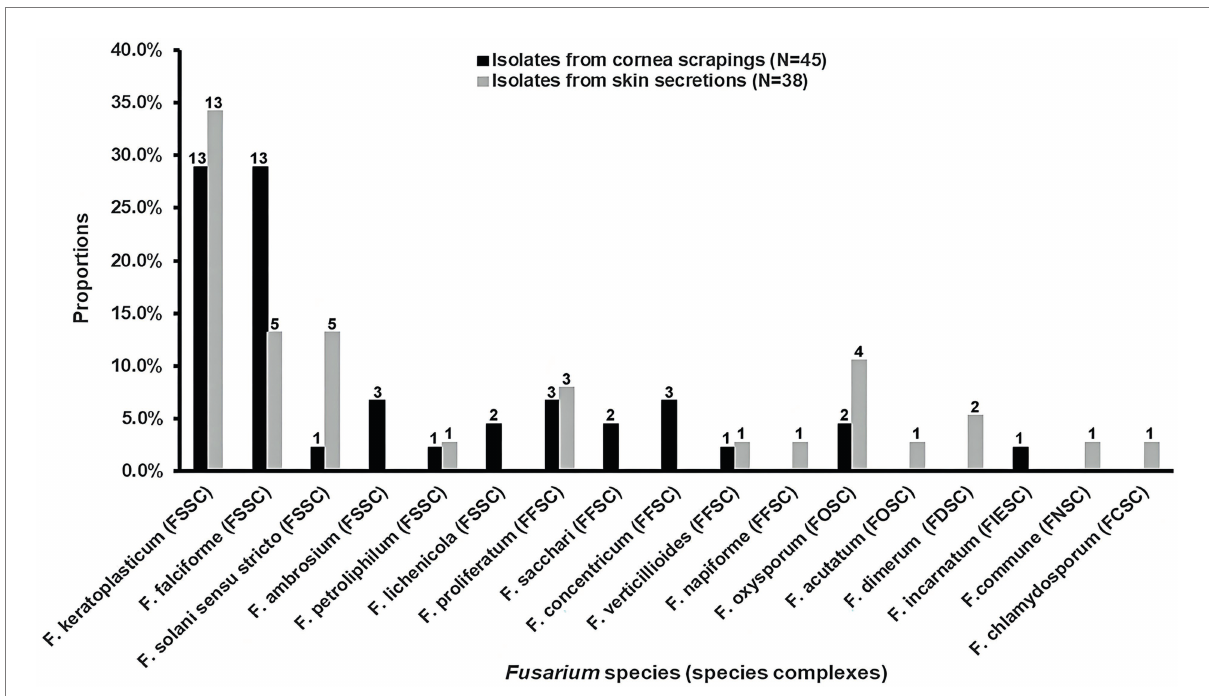
FIGURE 1 The distributions and proportions of Fusarium strains among isolates from cornea scrapings and skin secretions, respectively. FSSC, F. solani species complex (SC); FFSC, F. fujikuroi SC; FOSC, F. oxysporum SC; FDSC, F. dimerum SC; FIESC, F. incarnatum-equiseti SC; FNSC, F. nisikadoi SC; FCSC, F. chlamydosporum